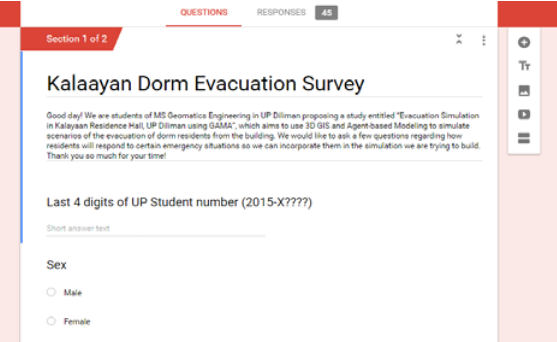
Figure 5. Interface of the online survey using Google Docs